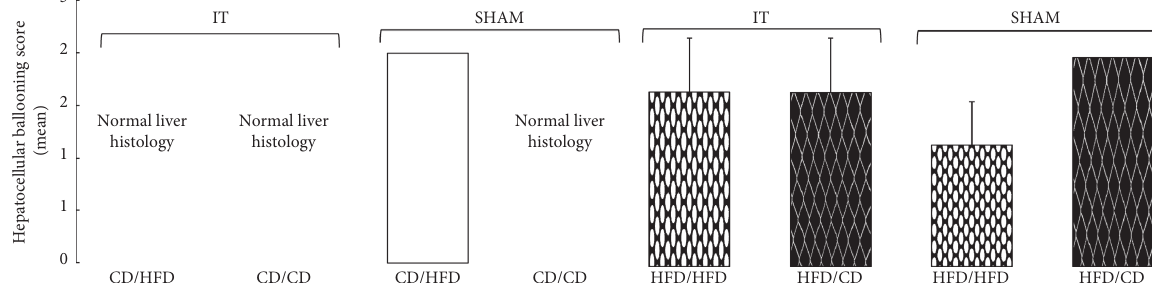
Figure 7: Liver histopathology. Distribution of normal and degenerated hepatocytes (ballooning degeneration) in four diet groups according to the operation type (ITand SHAM). Abbreviations: IT—ileal transposition, SHAM—sham operated animals, CD—control diet, and HFD—high-fat diet. Preoperative diet/postoperative diet: CD/HFD, CD/CD, HFD/HFD, HFD/CD. Data are presented as the means ± SEM.